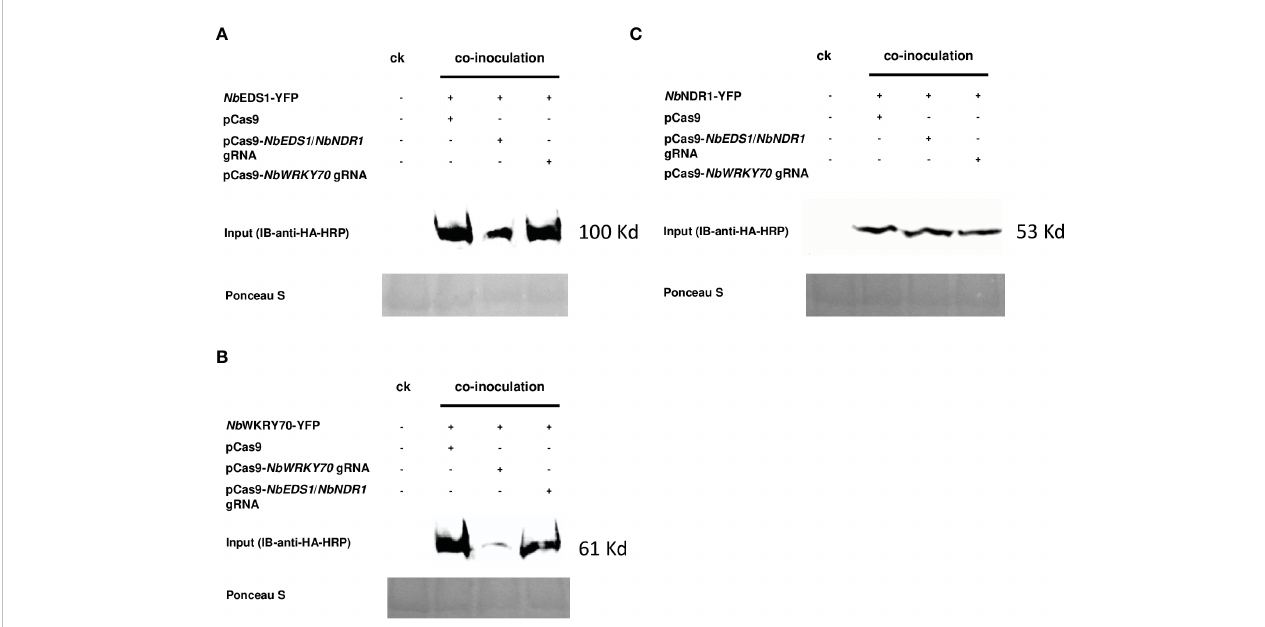
FIGURE 2 Image of the western blot used to detect the YFP fusion proteins. The protein accumulation of (A) NbEDS1 -YFP, (B) NbWRKY70 -YFP, and (C) NbNDR1 - YFP were detected by probing the blot with anti-HA-HRP antibodies. (A) tumefaciens strains carrying p35S:: NbEDS1 -YFP, NbWRKY70 -YFP, and p35S:: NbNDR1 -YFP, were co-inoculated with pCas9 empty vector, pCas9- NbEDS1 / NbNDR1 gRNA, and pCas9- NbWRKY70 gRNA onto the N. benthamiana leaf, respectively. CK: the protein was extracted from N. benthamiana leaf in fi ltrated with 10 mM MgCl 2 that served as a negative control. The blot membrane was stained with Ponceau S to con fi rm equivalent loadings. +: present of the indicated construct, -: absence of the indicated